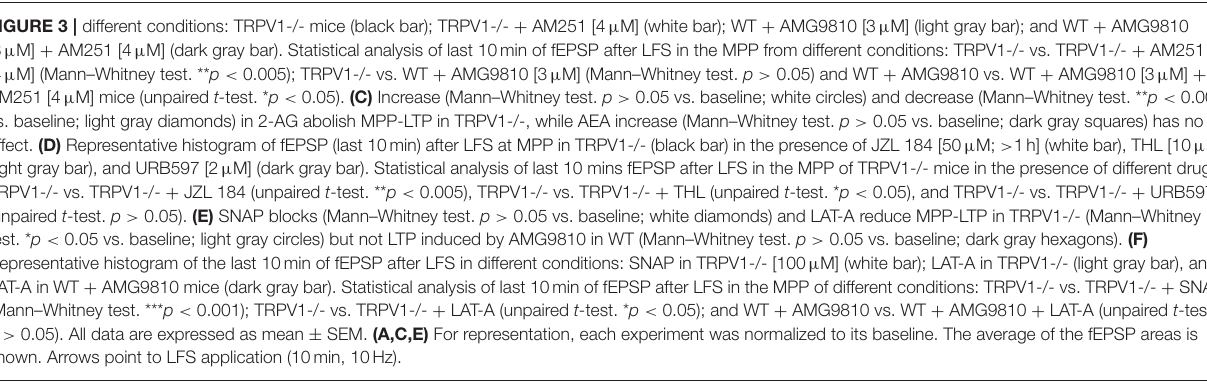
FIGURE 3 | different conditions: TRPV1-/- mice (black bar); TRPV1-/- + AM251 [4 µ M] (white bar); WT + AMG9810 [3 µ M] (light gray bar); and WT + AMG9810 [3 µ M] + AM251 [4 µ M] (dark gray bar). Statistical analysis of last 10min of fEPSP after LFS in the MPP from different conditions: TRPV1-/- vs. TRPV1-/- +